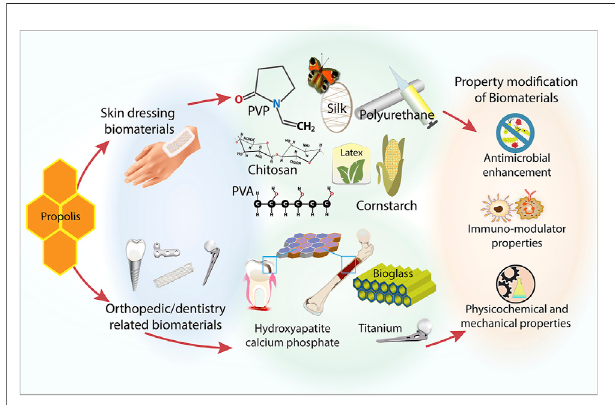
FIGURE 1 | The potential role of propolis as a component of